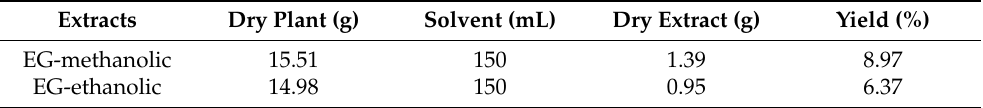
Table 1. Ethanolic and methanolic yield of extracts.